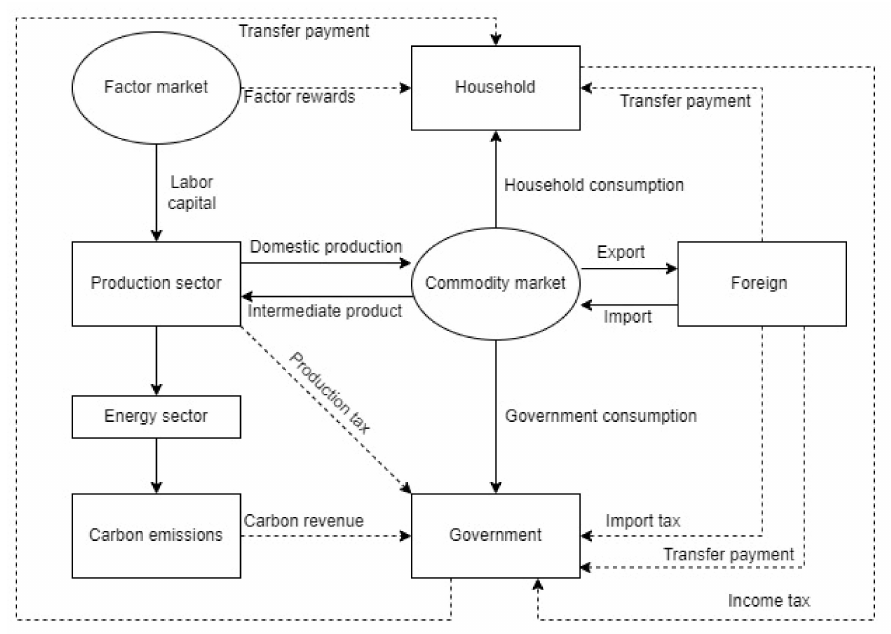
Figure 1. The CGE model framework